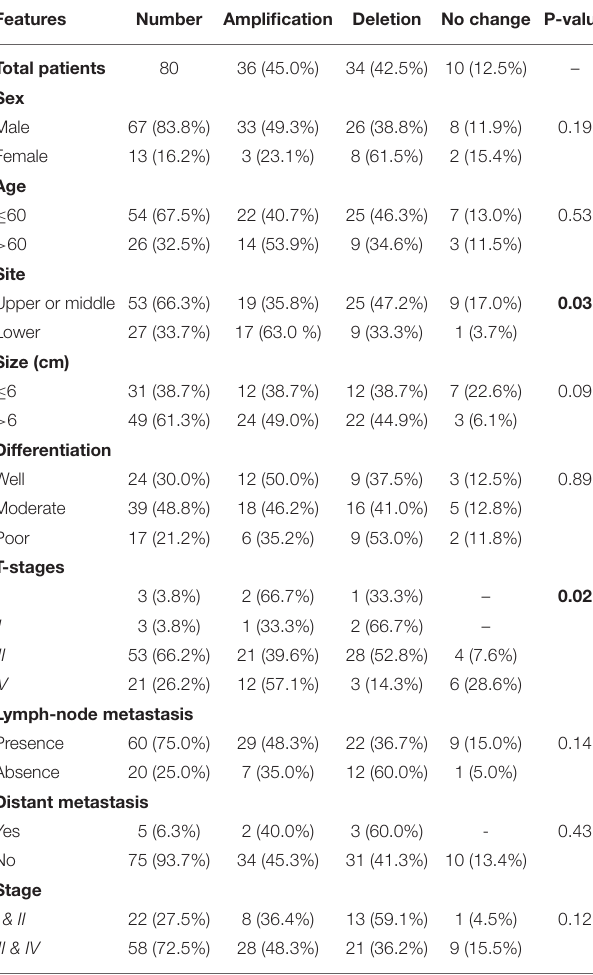
TABLE 3 | Correlation of EPAS1 DNA variations with clinicopathological features of patients with esophageal squamous cell carcinoma.